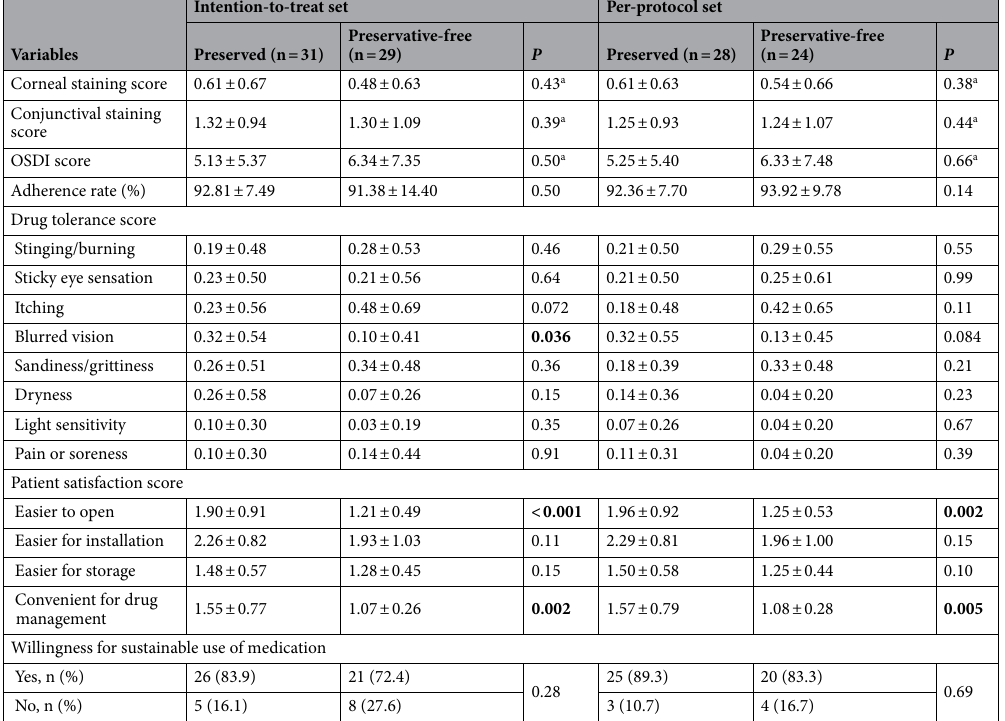
Table 2. Primary outcome measurements at 12-week visit. OSDI ocular surface disease index. a Statistical analyses are conducted using ANCOVA after adjusting baseline data. Significant values with P < 0.05 are indicated in bold.